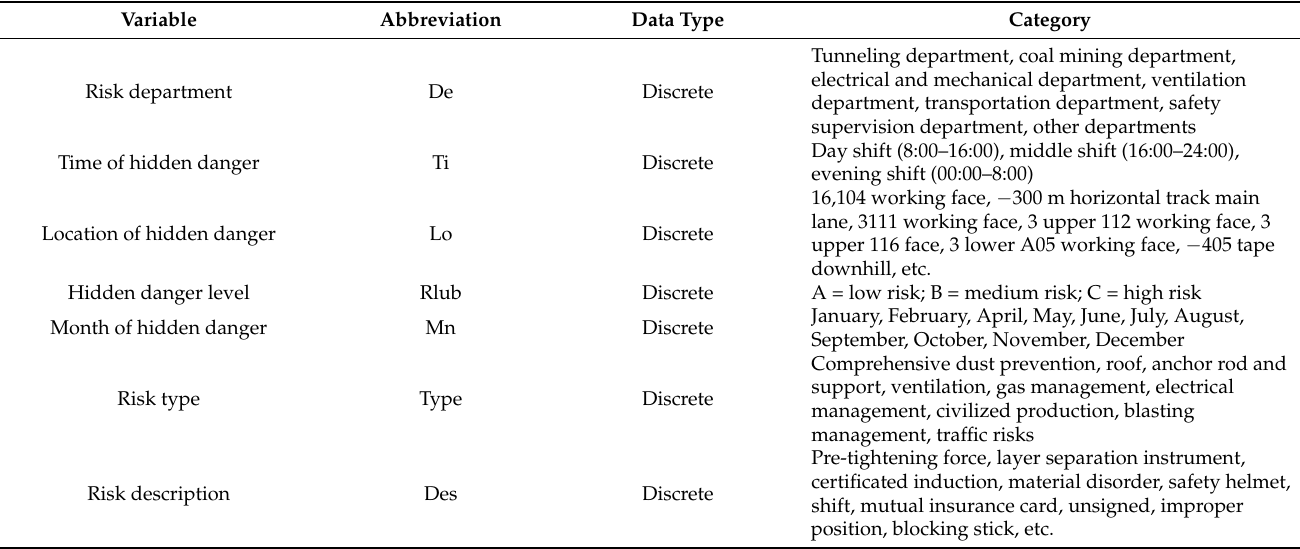
Table 1. Combined statistics on hidden risks in coal mines.